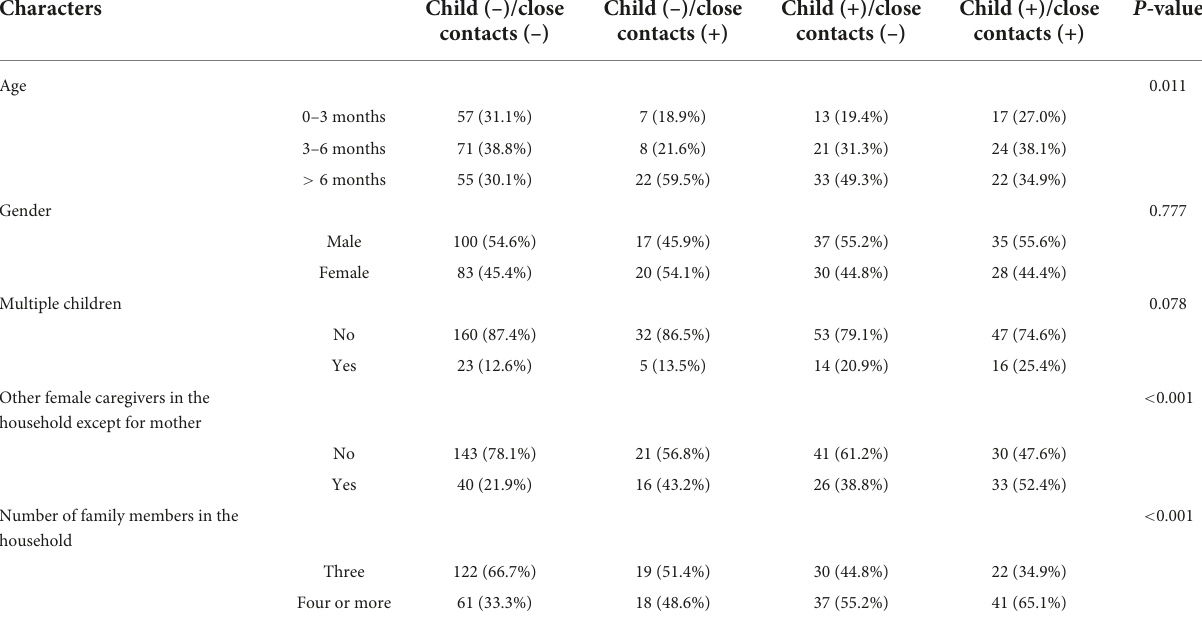
TABLE 3 Differences in age, gender and family-related factors across subgroups ( n =